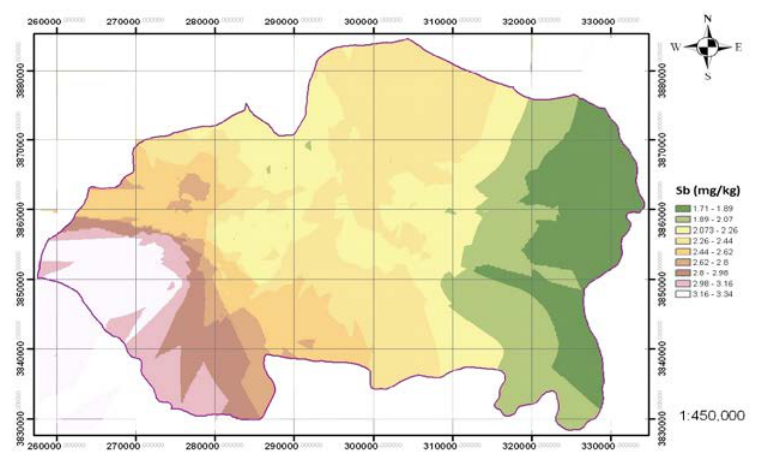
Fig. 6: Spatial distribution of antimony in soil of Hamedan